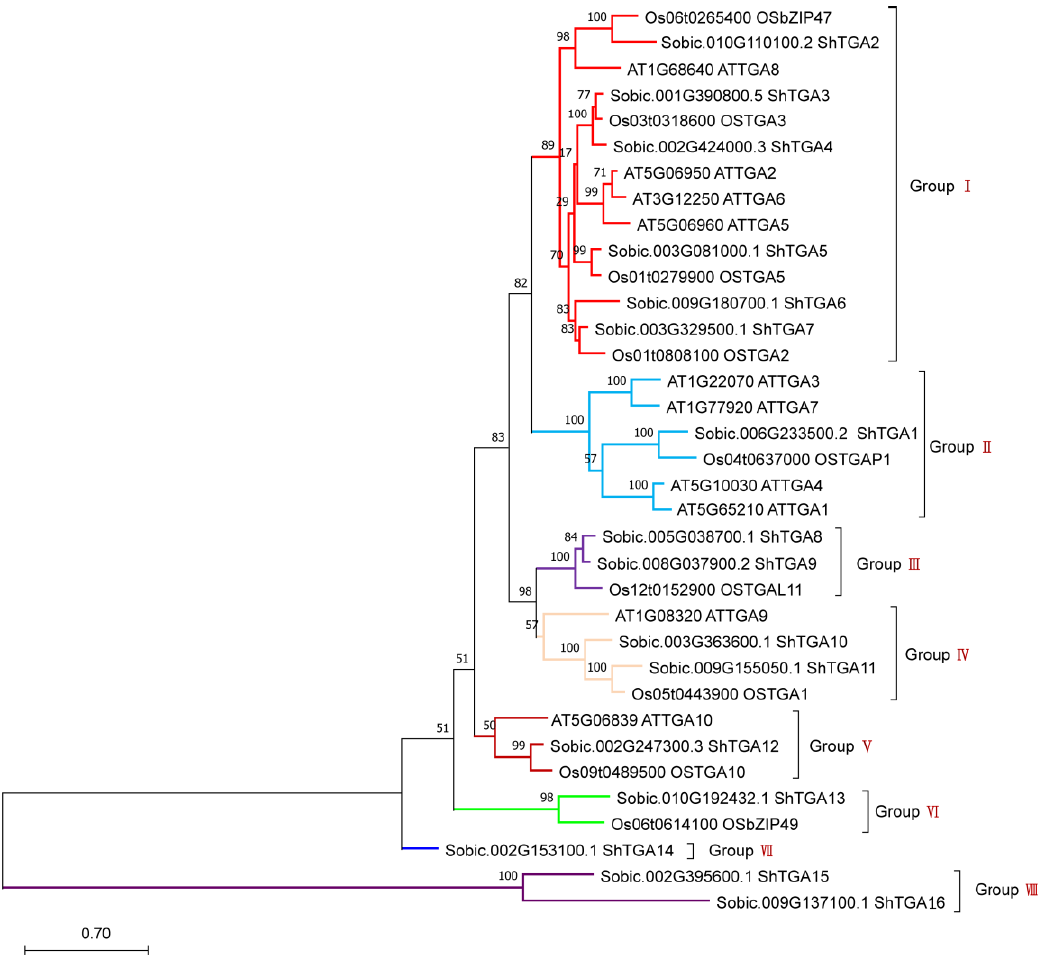
Figure 2. Maximum likelihood phylogenetic analysis of TGA families from Arabidopsis , rice and sugarcane. Protein sequences were aligned using MUSCLE, and phylogenetic tree reconstruction was made using maximum likelihood method under the best model selection in MEGA11 software with 1000 replicates of rapid bootstrap and LRT statistics. The bootstrap value in which the associated taxa clustered together are shown next to the branches. The scale bar represents 0.07 units of amino acid substitutions per site.